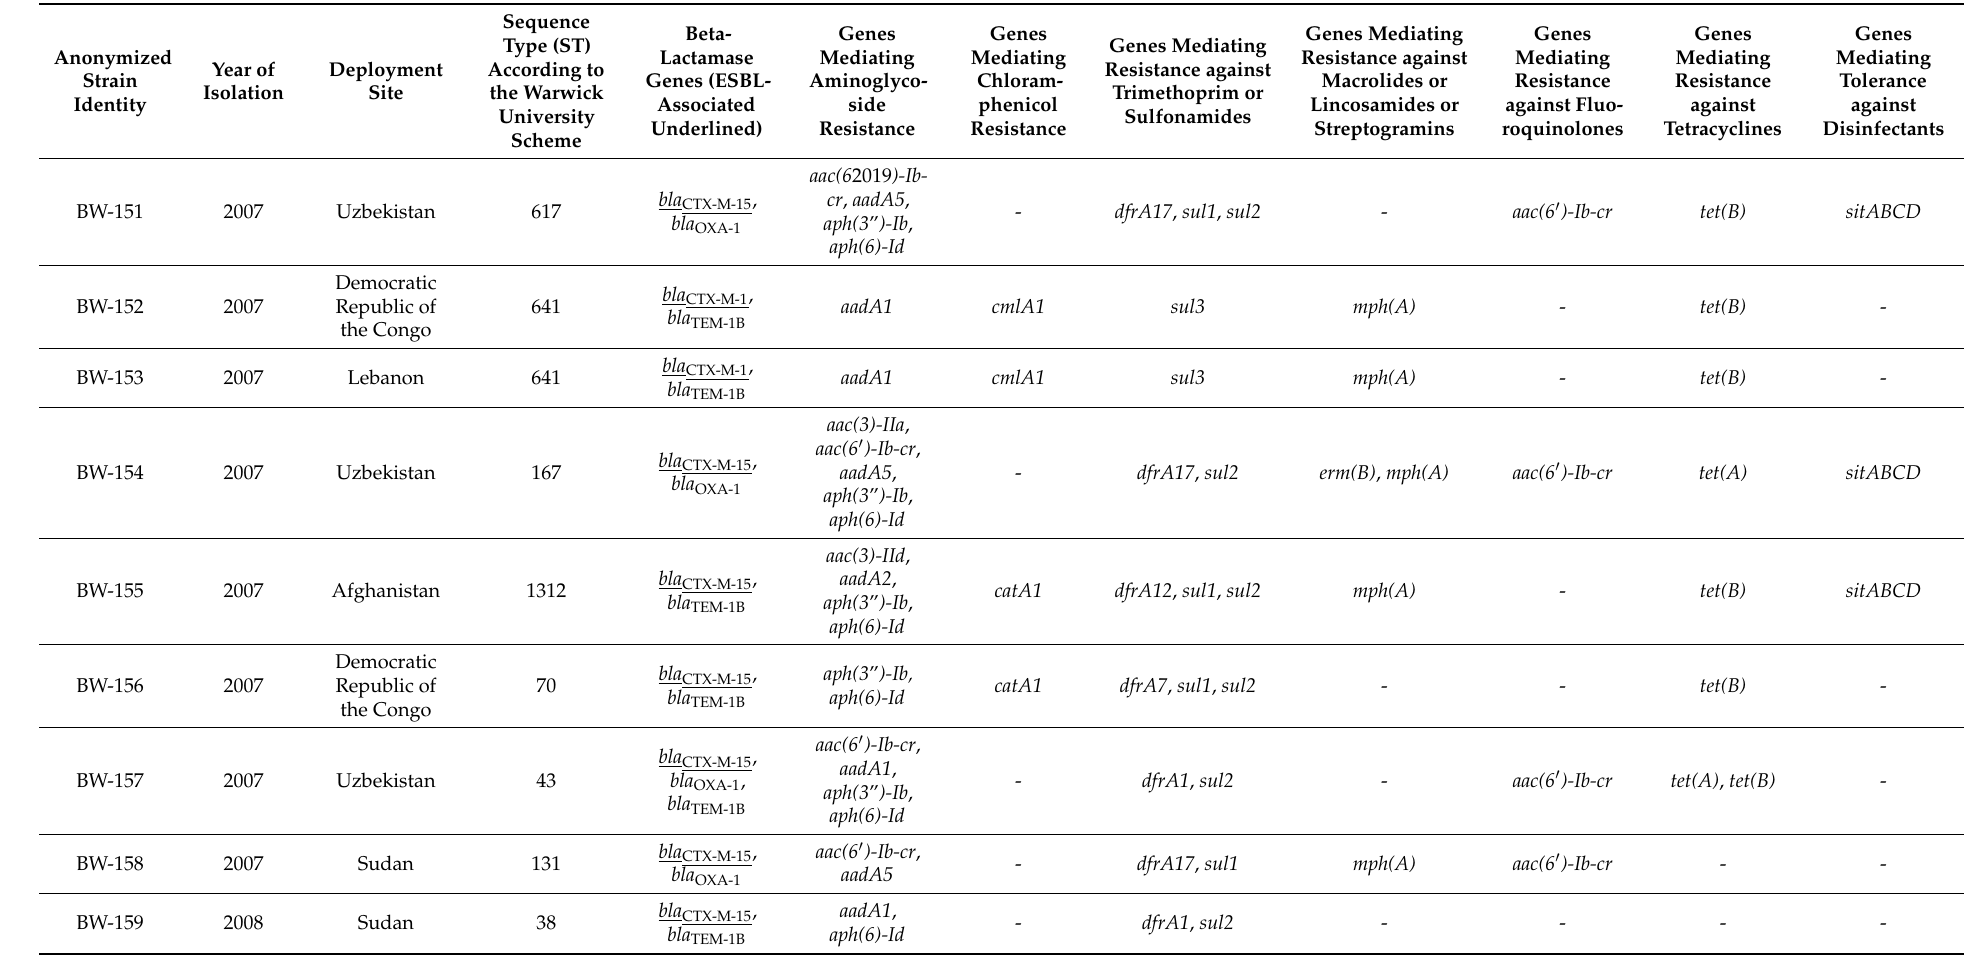
Table 2. Sequence types (STs) according to the Warwick University scheme and acquired molecular resistance mechanisms in the assessed ESBL-positive E. coli isolates detected by Resfinder with a sequence identity and coverage of ≥